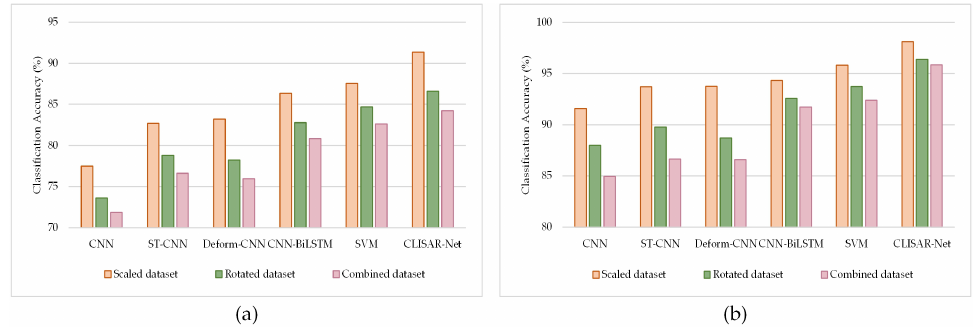
Figure 10. Comparisons of involved methods on three datasets. ( a ) Classification results using 5% of labeled training samples and ( b ) classification results using 100% of labeled training